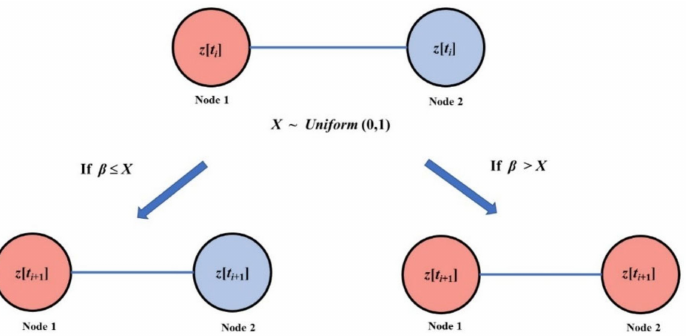
Figure 5. Conceptual layout for the transmission of contagion between nodes based on the Monte Carlo method. When the transmission rate ( β ) is larger than a random real number ( X ), a susceptible node (blue) becomes an infective node (red) at time t +